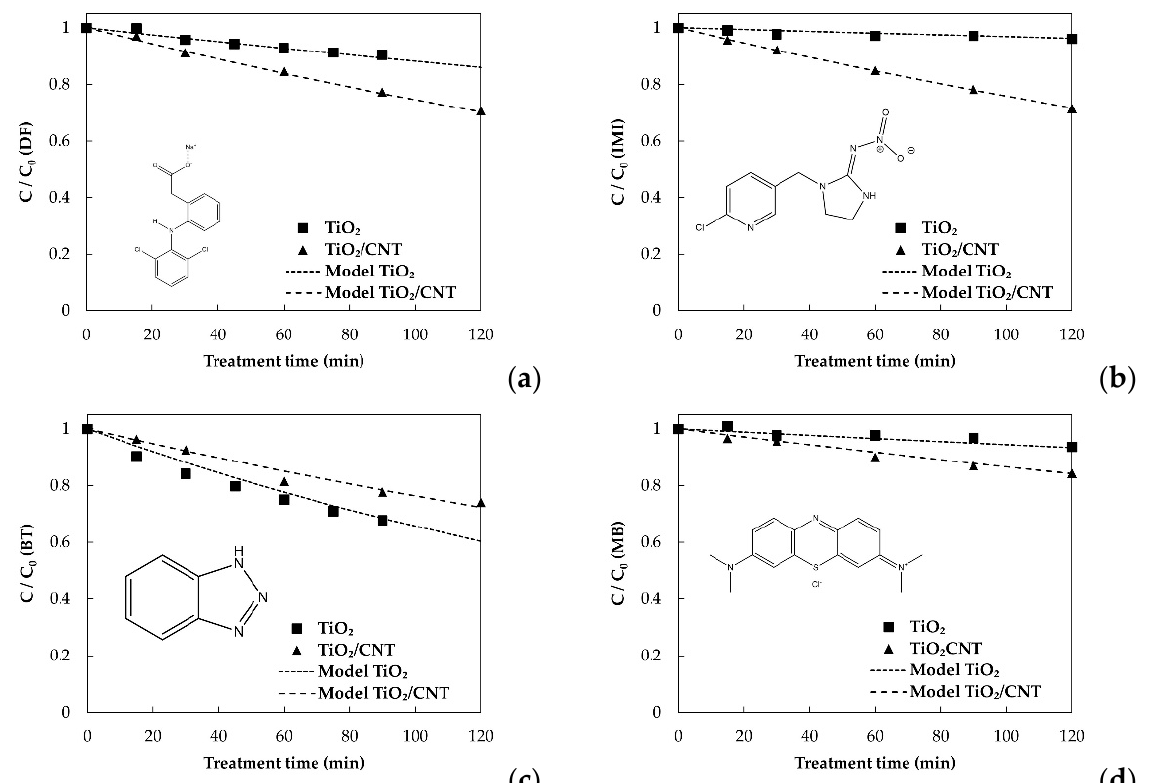
Figure 5. Photocatalytic degradation on TiO 2 and TiO 2 /CNT of: ( a ) diclofenac (DF), ( b ) imidacloprid (IMI), ( c ) 1H-benzotriazole (BT), ( d ) methylene blue (MB). Fitting of mathematical modelling results along with the obtained experimental data.